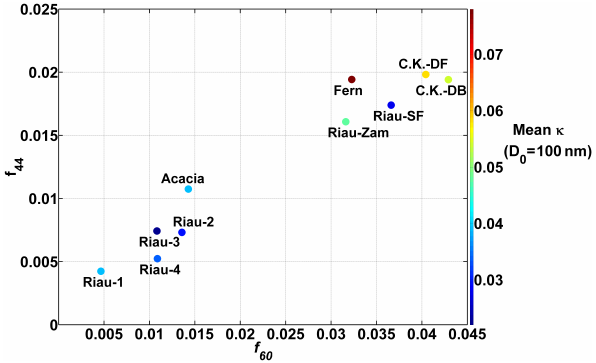
Figure 7. Correlation of f 44 and f 60 for different types of Indone- sian peat and